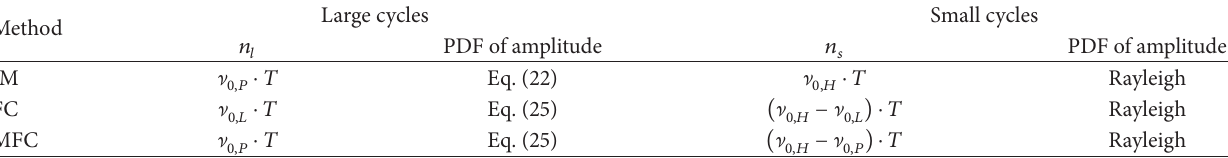
Table 1: Comparison of large cycles and small cycles for different spectral methods.